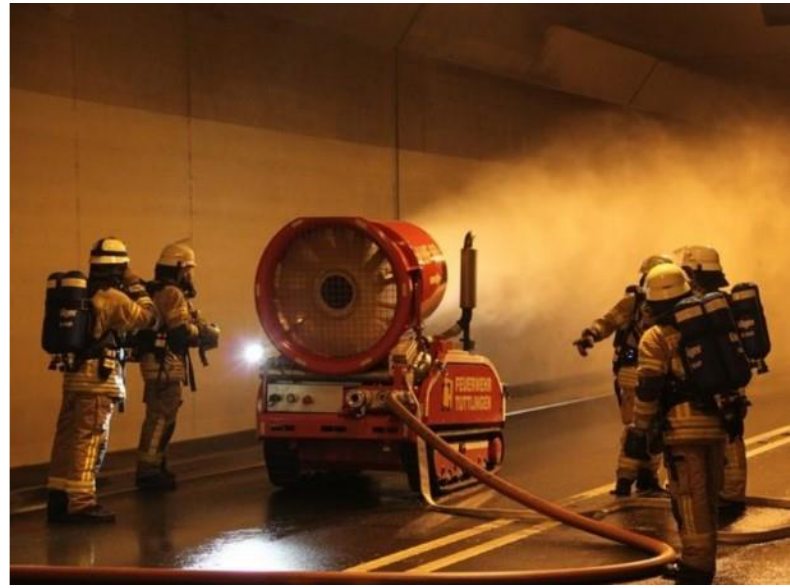
Figure 1. LUF60 robot.